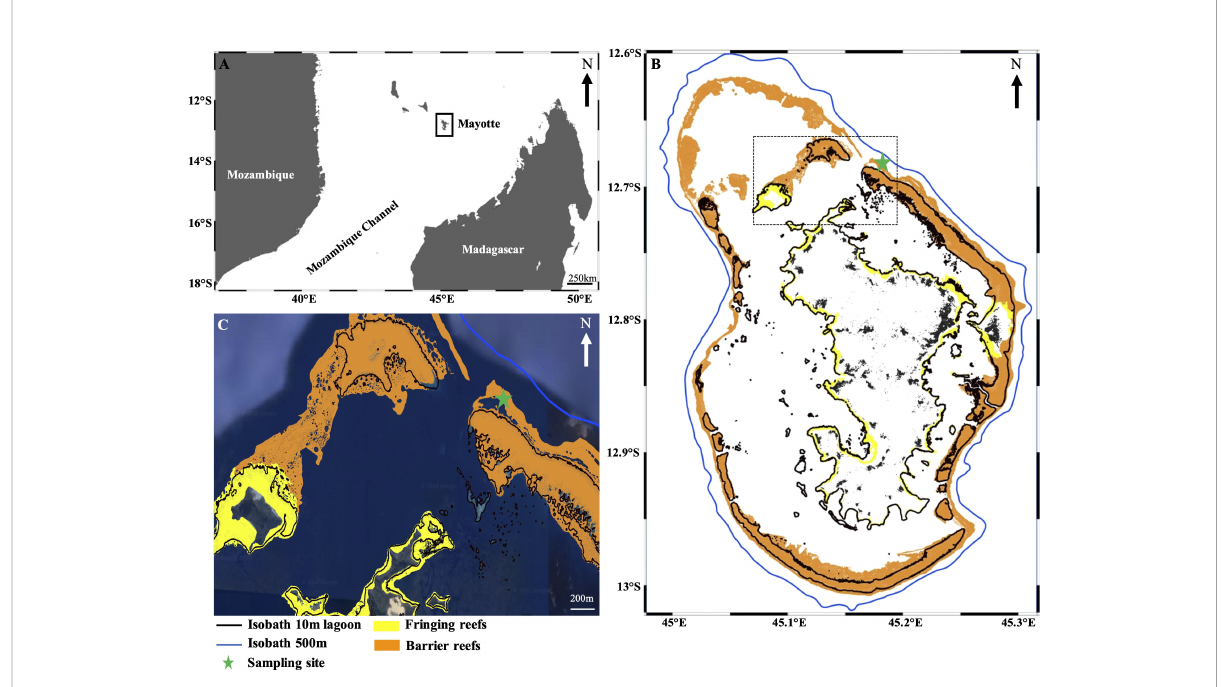
FIGURE 1 Location of the sample site. (A) Mayotte in the Western Indian Ocean (WIO). (B) Reef ecosystems around Mayotte. The blue line and black lines represent the different isobaths around the island. The green star indicates the sampling location in the northeastern part of the lagoon (C) Details of the northeastern part of the lagoon showing the barrier reef near the M ’ Tsamboro pass and the sampling location on the outer slope (green